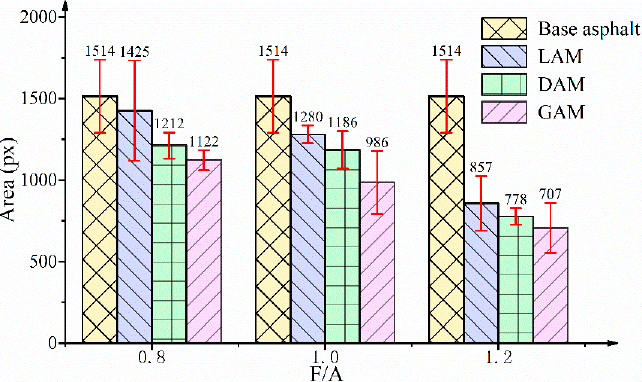
Figure 9. Bee phase area of asphalt mastics.